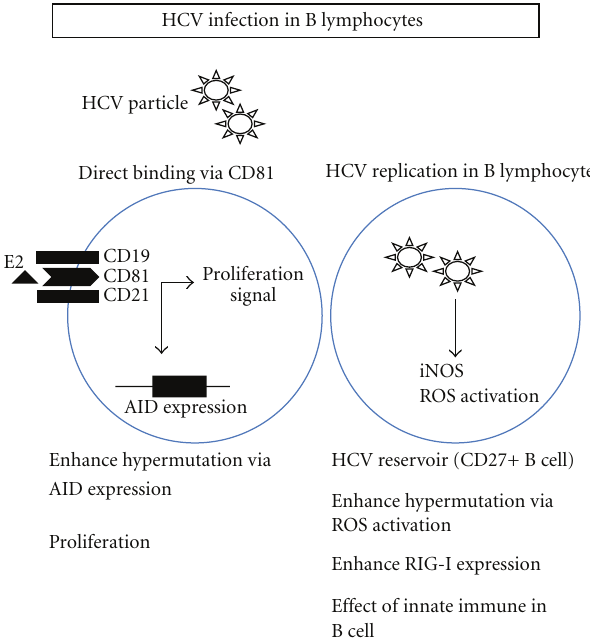
Figure 1: A schema of the biological significance of HCV replica- tion in B cells is shown. The representative e ff ects of lymphotropic HCV on B cells are shown in this